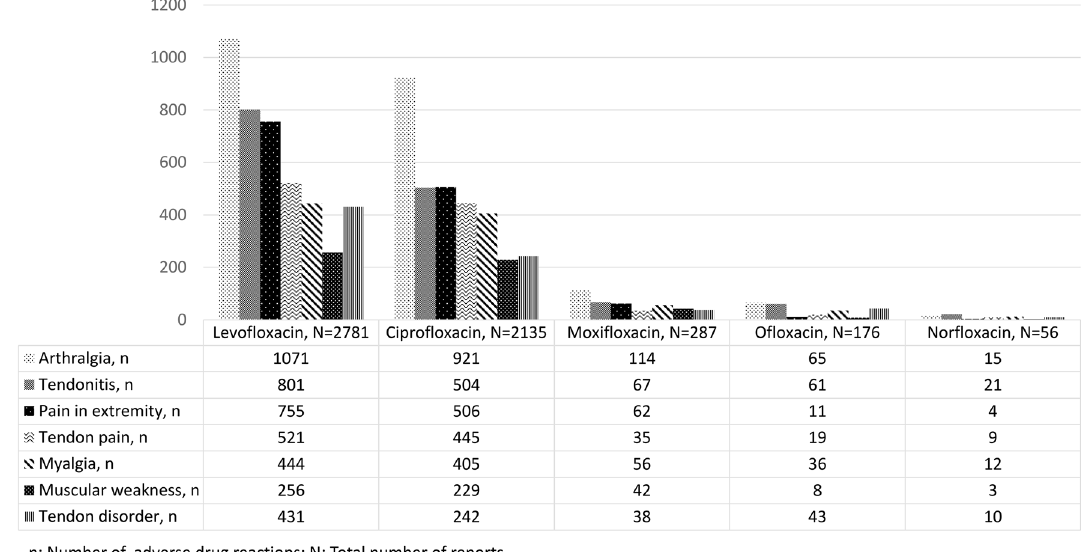
Figure 3. Top most frequent FQs suspected in the reports with musculoskeletal ADRs. ADRs adverse drug reactions; FQ fluoroquinolone. More than one ADR could be reported per FQ.